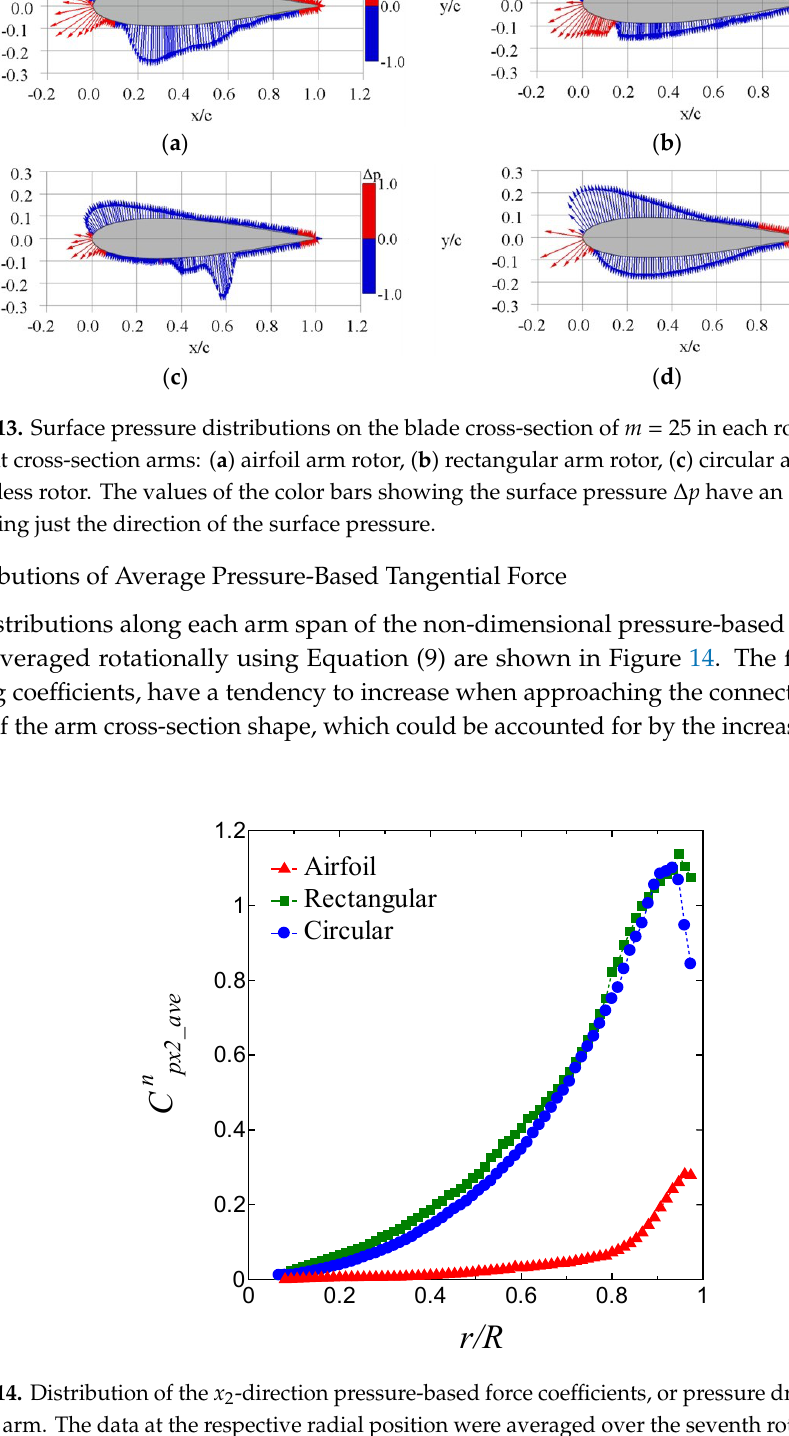
Table 3. Pressure-based tangential force coefficients averaged along the arm span direction.